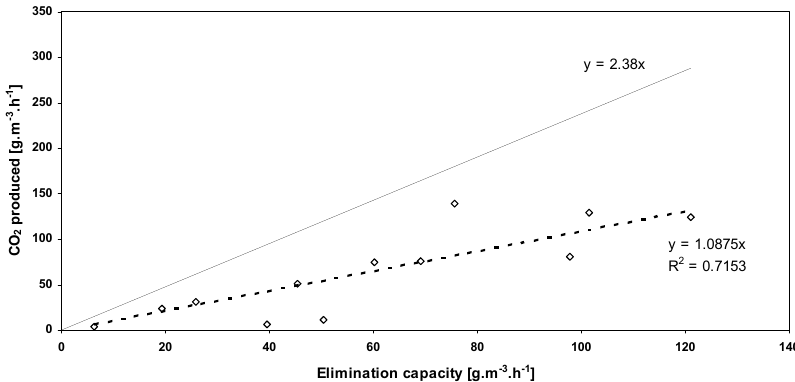
Figure 5. CO 2 produced as a function of the butanol elimination capacity, compared to the theoretical relationship (slope 2.38) with complete and stoichiometric conversion.